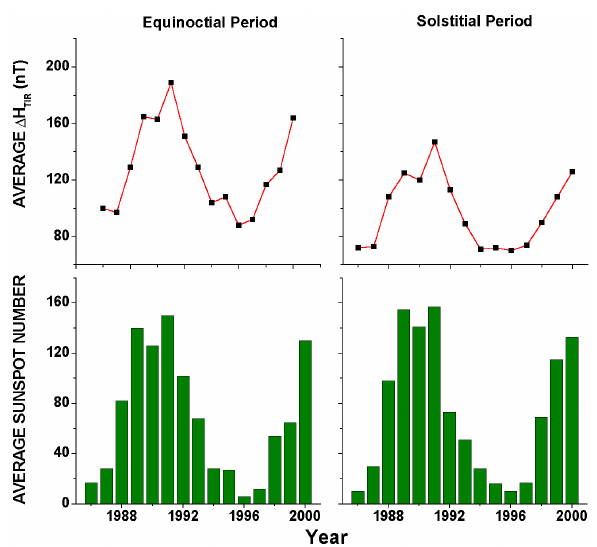
Fig. 2. Variations in the average noontime values of 1 H TIR with the average values of sunspot numbers for the equinoctial and the solstitial months during 1986–2000. Magnetically quiet days with A p ≤ 15 only are included.